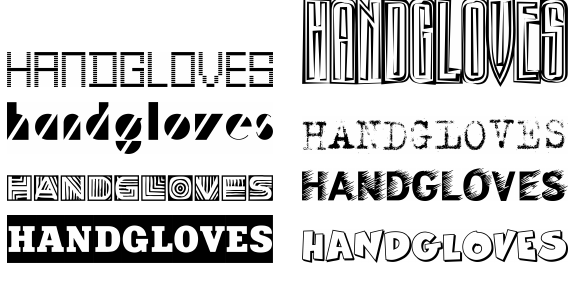
Figure 5. Atypical fonts